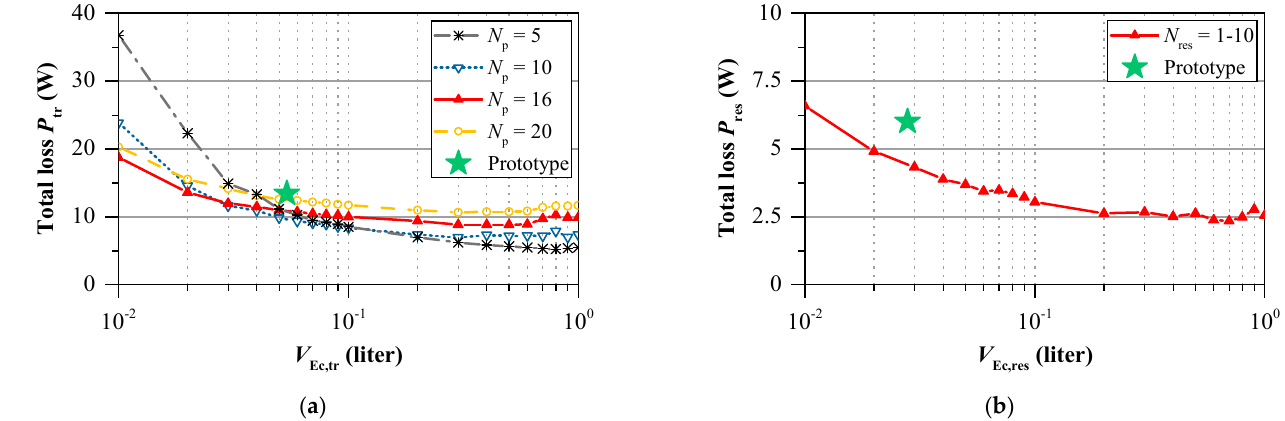
Figure 18. Loss P versus volume V Ec,x Pareto frontier for ( a ) the transformer and ( b ) the resonance inductance.